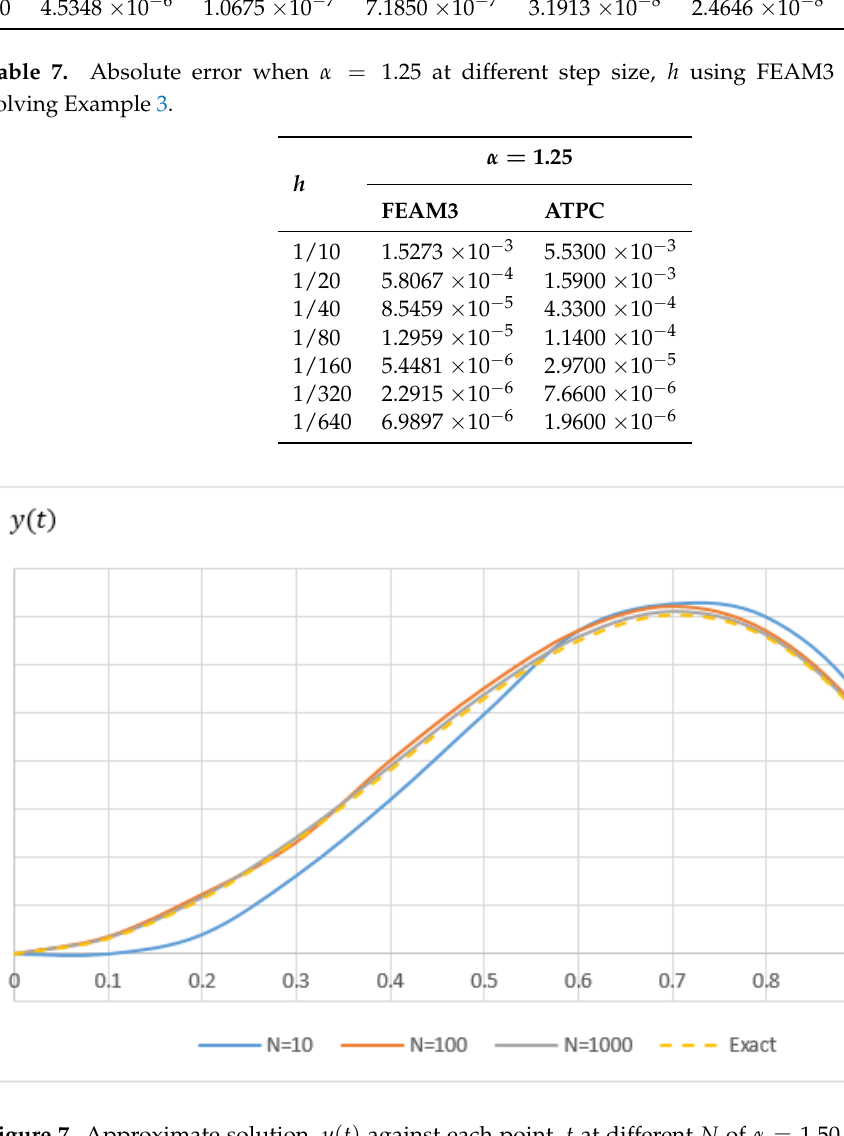
Figure 7. Approximate solution, y ( t ) against each point, t at different N of α = 1.50 when solving Example 3 using